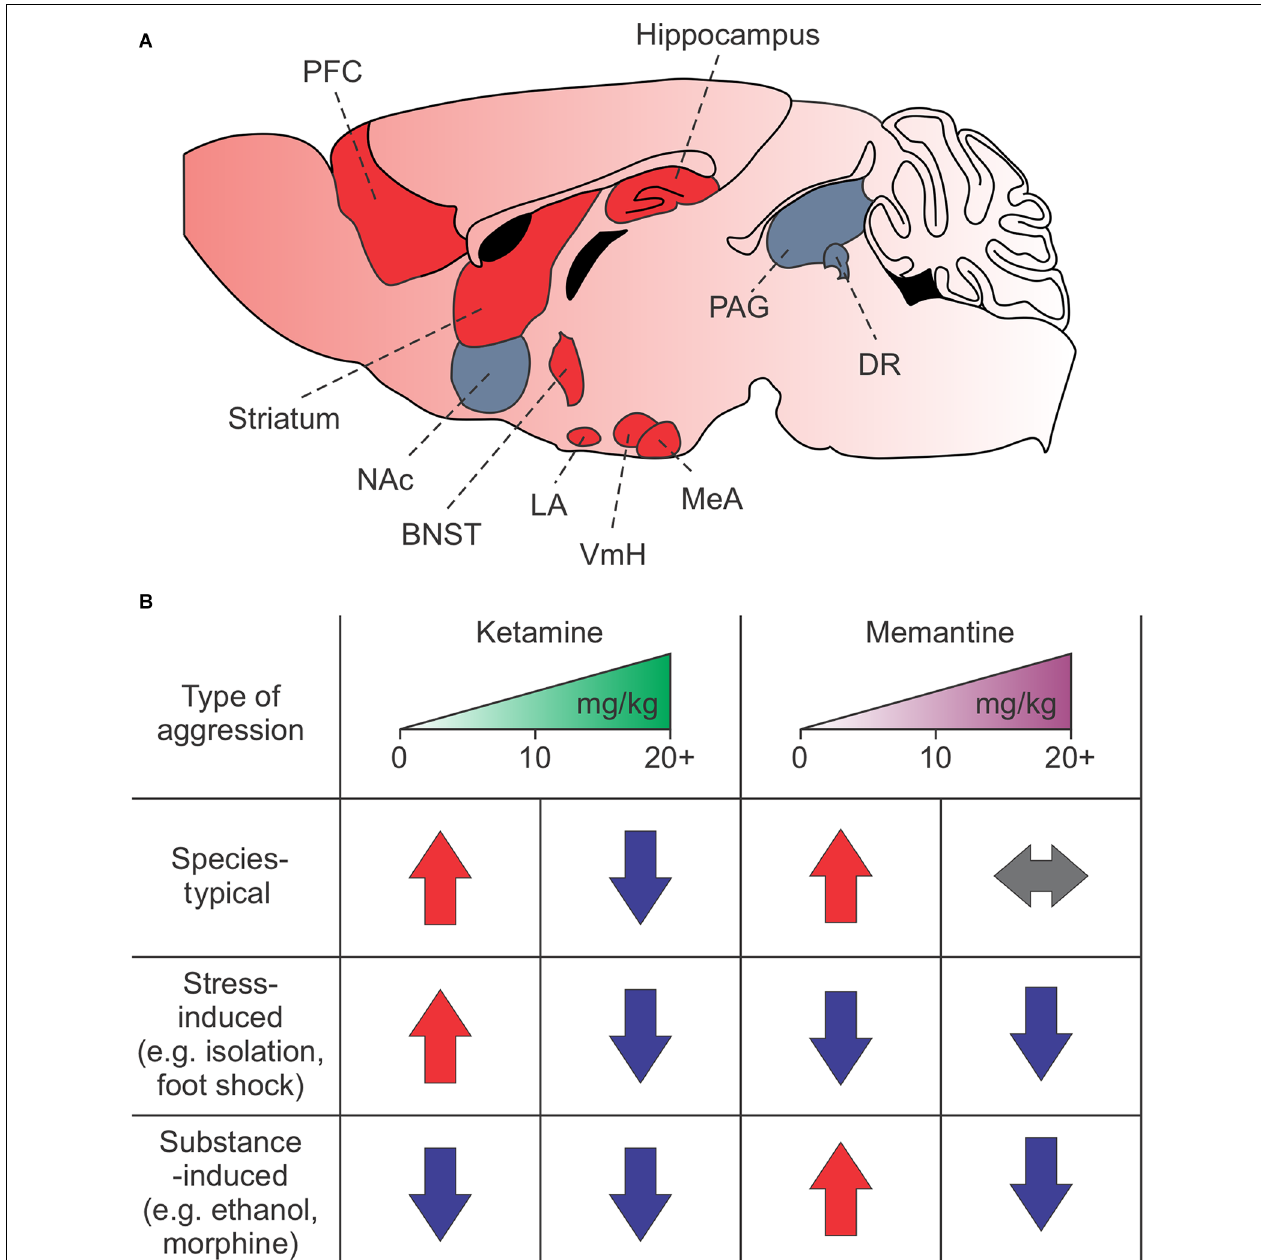
FIGURE 1 | Summary of NMDAR-dependent aggression in mice. (A) Brain regions associated with attack behavior are enriched in and regulated by NMDARs. Red regions indicate known areas involved in NMDAR-dependent synaptic plasticity-induced aggression. (B) Effects of low or high doses of ketamine and memantine on species-typical, stress-induced, and drug or alcohol-induced aggression. Red arrows—increased aggression; blue arrows—decreased aggression; gray arrows—no change in aggression. The PFC, prefrontal cortex; NAc, nucleus accumbens; BNST, bed nucleus of the stria terminalis; LA, lateral amygdala; VmH, ventromedial hypothalamus; MeA, medial amygdala; PAG, periacqeductal gray; DR, dorsal